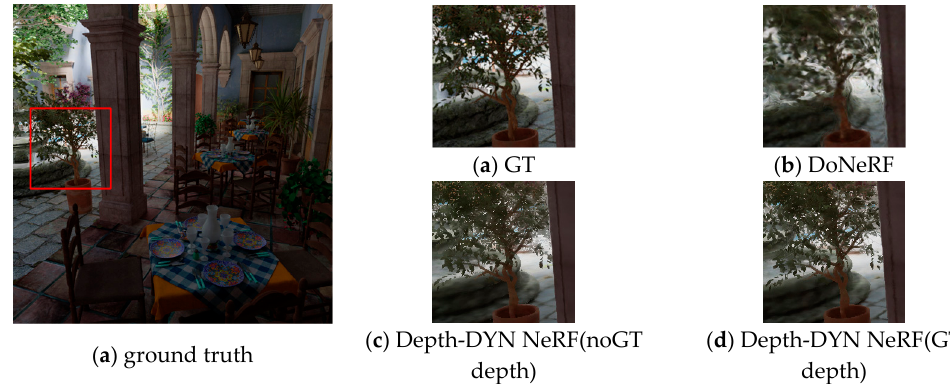
Figure 10. Results of synthetic depth rendering.